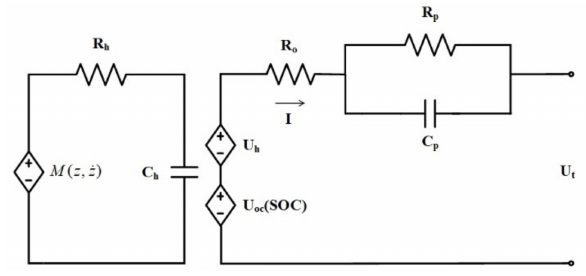
Figure 6. 1-RC model with one-state hysteresis